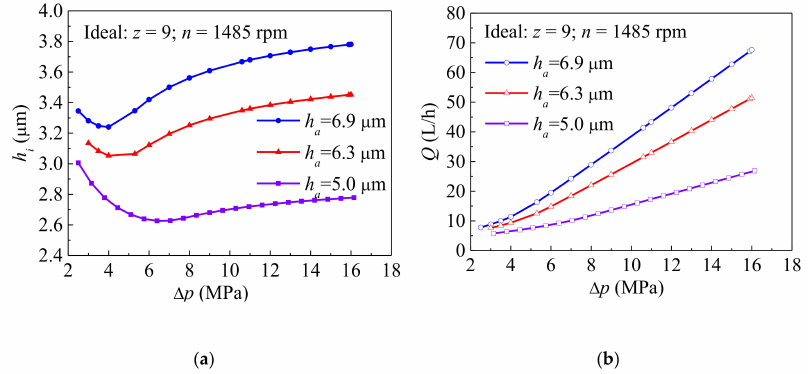
Figure 3. Comparison of minimum fluid film thickness h i ( a ) and leakage rate Q ( b ), including waviness amplitude h a . The viscosity is taken as 1.003 × 10 − 3 kg / (m ·